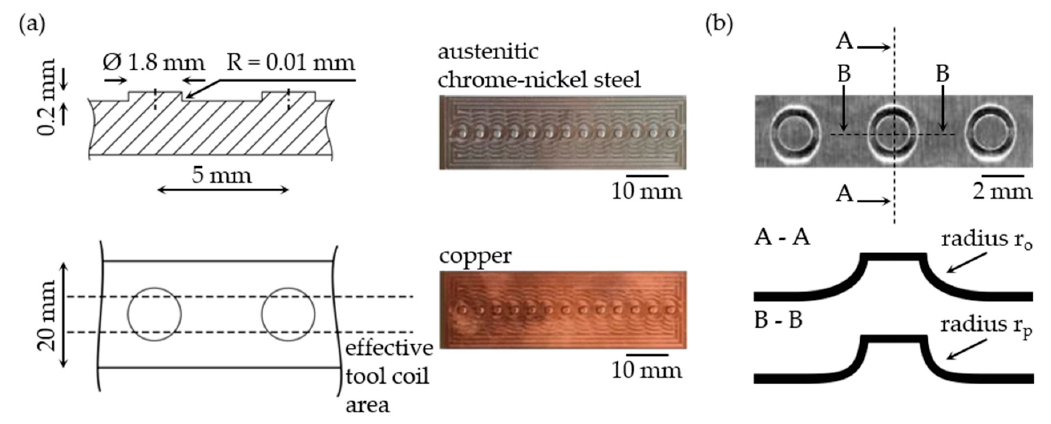
Figure 4. Embossing experiment; ( a ) die geometry; ( b ) resulting workpiece geometries.